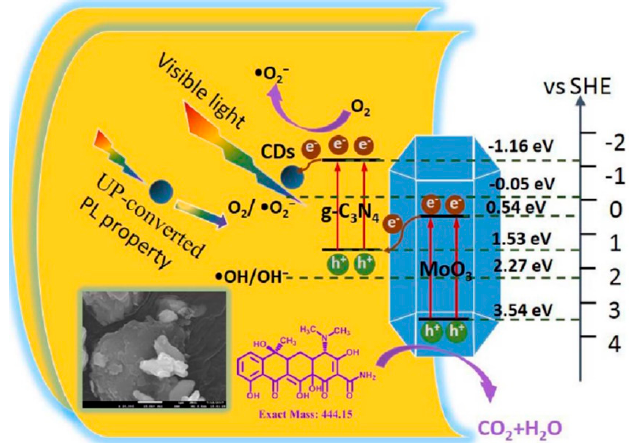
Figure 13. Photocatalytic activity ( a ) and recycling performance ( b ) of BCCN-30 for ciprofloxacin (CIP) degradation under visible-light irradiation (reproduced with permission from [91]. Copyright Elsevier, 2018).